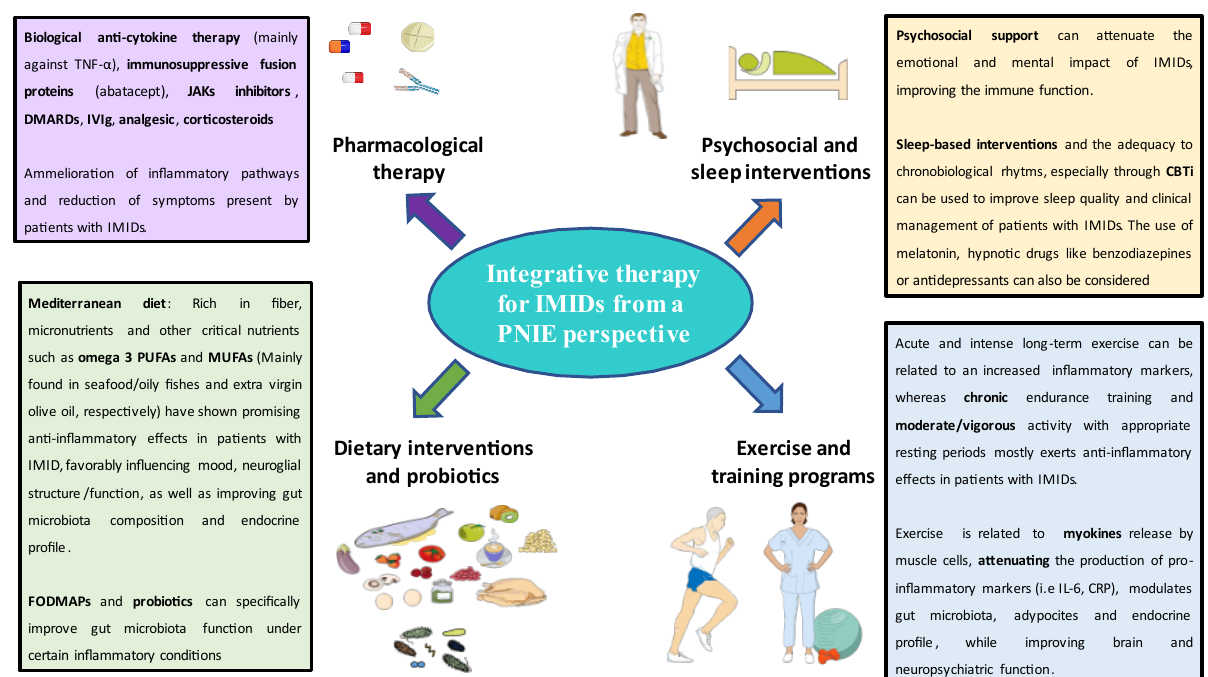
Figure 2. A holistic view of the potential treatment of IMIDs from a PNIE perspective. A holistic view of the PNIE is that all physical illness entails mental illness. Together with the concept of psychosomatic therapy, this reminds us of the famous physician and philosopher Hippocrates (460–370 BC), who said, “The natural force within each of us is the greatest healer of all”.